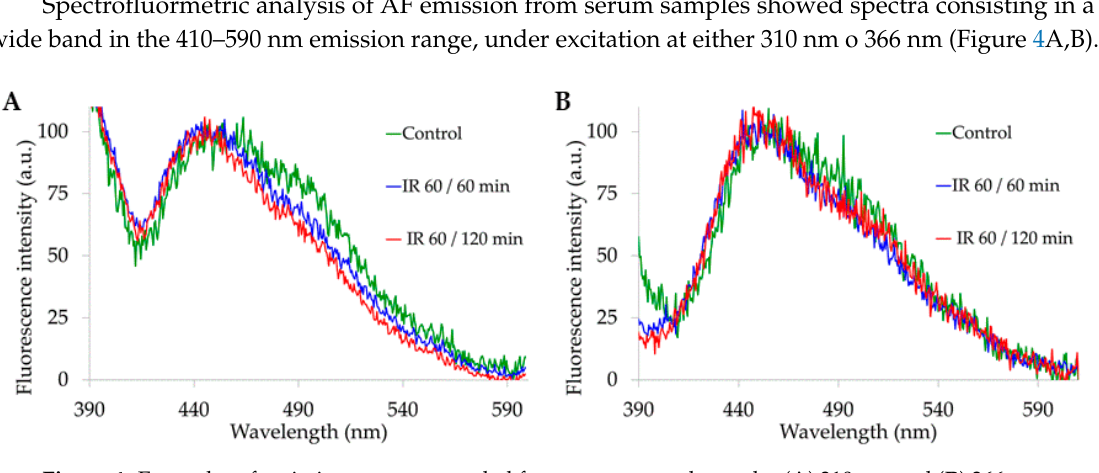
Figure 4. Examples of emission spectra recorded from serum samples under ( A ) 310 nm and ( B ) 366 nm excitation. Spectra are normalized to the maximum peak value. Rat liver treatment conditions are indicated by colors.